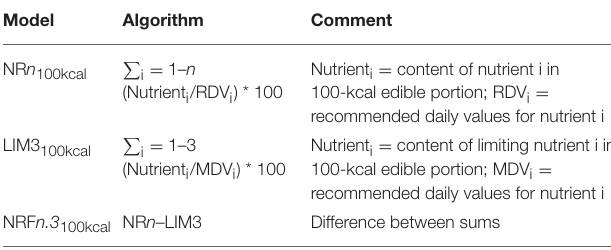
TABLE 2 | Dietary reference values for selected nutrients used in developing the E-NRF7.3. Nutrient RDV